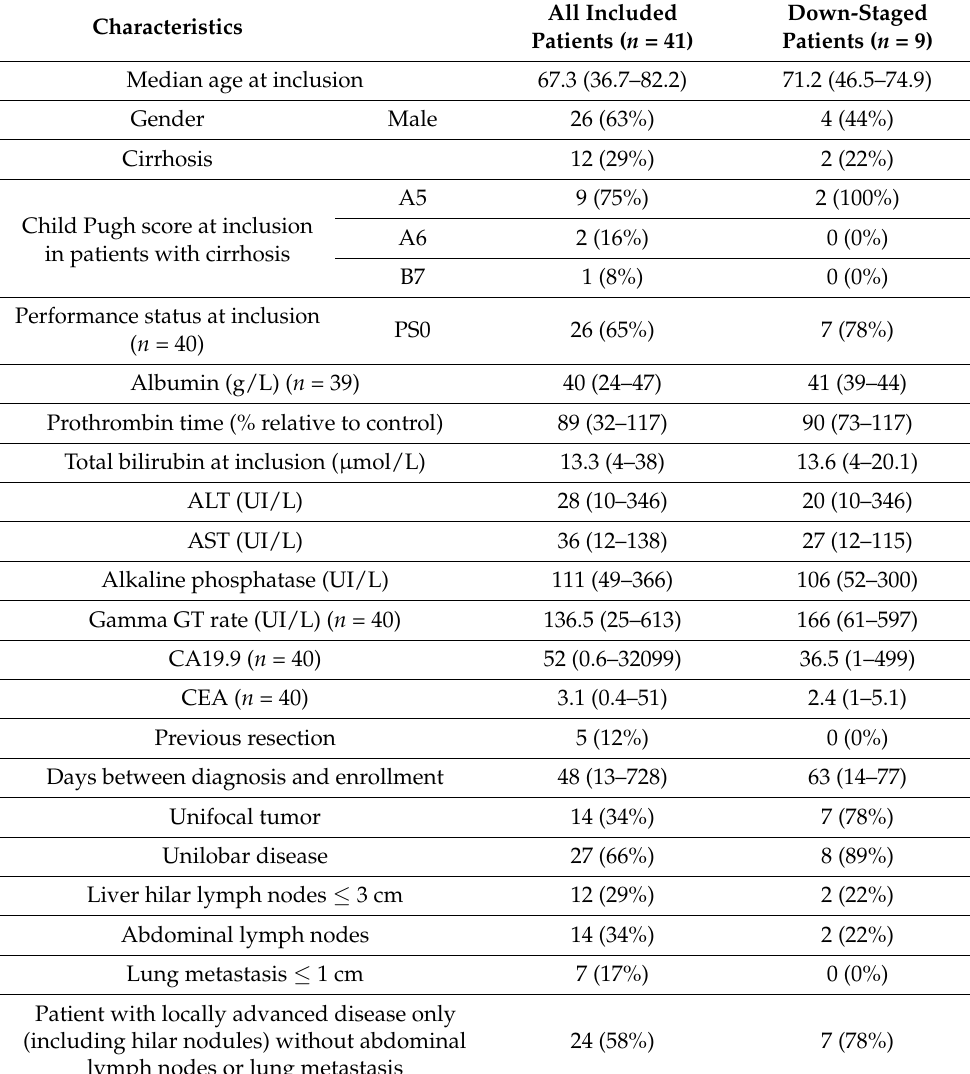
Table 1. Characteristics of the patients